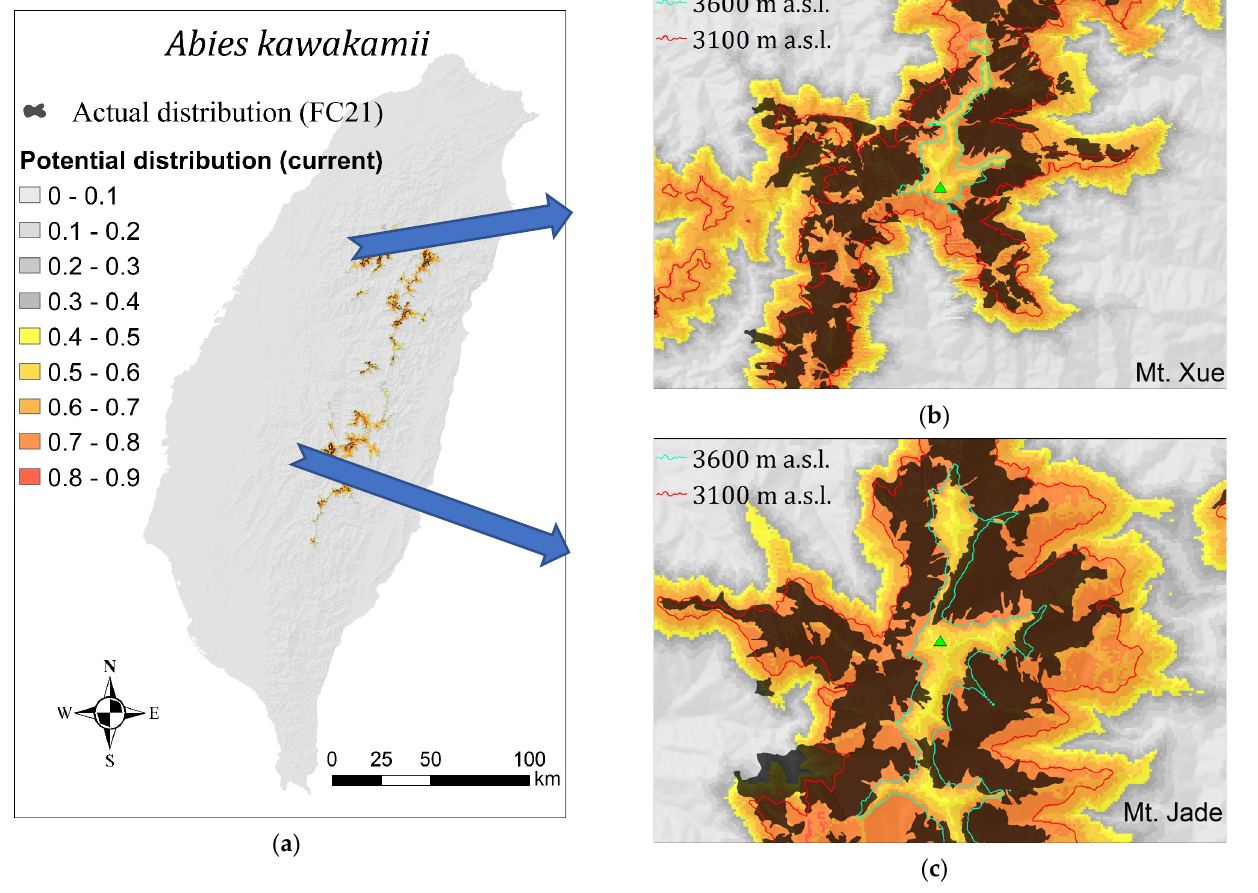
Figure 2. Potential (occurrence probability under the current climate, orange tone) and actual (FC21 formation, black polygon) distribution of Abies kawakamii forest. ( a ) Taiwan island, ( b ) Mount Xue, and ( c ) Mount Jade.